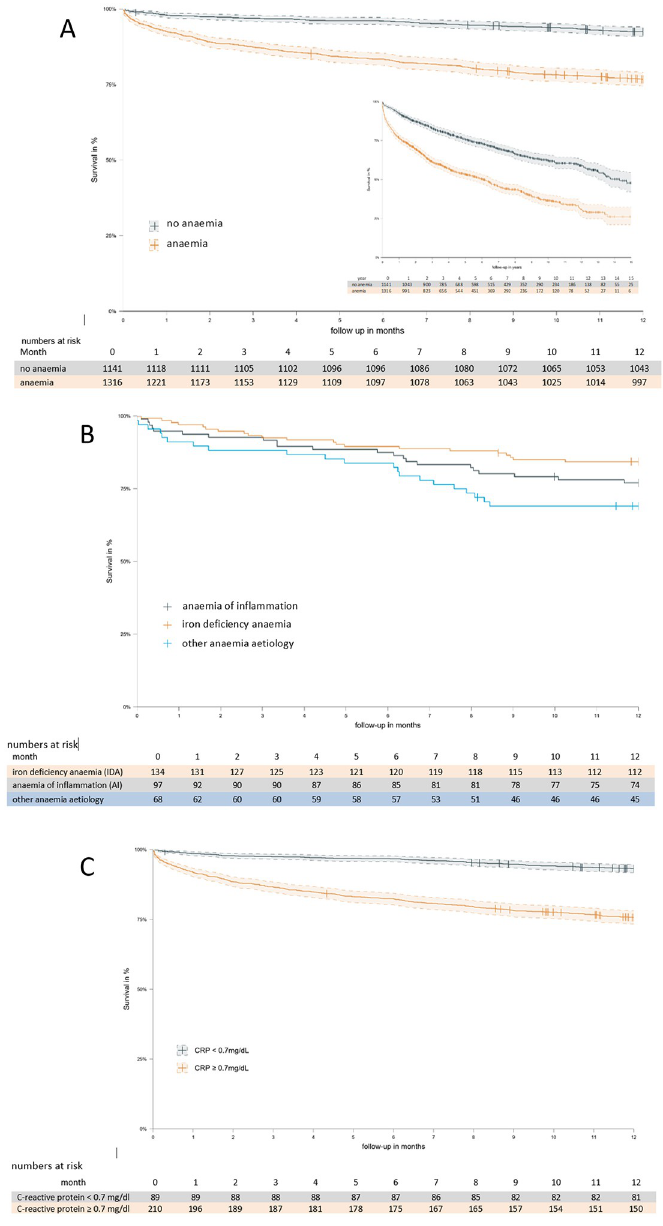
Fig 2. (A) Kaplan-Meier curves and 95% confidence intervals of overall survival during the first postoperative year and the 15 year follow up period (insert) in the cohort of 1316 patients stratified by anemia or no anemia. Differences between groups were analyzed by log-rank test (p < 0.001 for both analyses) (B) Kaplan-Meier curves showing the comparison of overall survival during the first postoperative year in the cohort of 299 patients grouped by anemia etiology as iron-deficiency anemia, anemia of inflammation or ‘other’ anemia etiologies. Differences between groups were analyzed by log-rank test (p = 0.03) (C) Kaplan-Meier curves and 95% confidence intervals showing the comparison of overall survival during the first postoperative year in the cohort of 1305 patients grouped by CRP < 0.7mg/dL or � 0.7mg/dL (log rank test; p < 0.001).